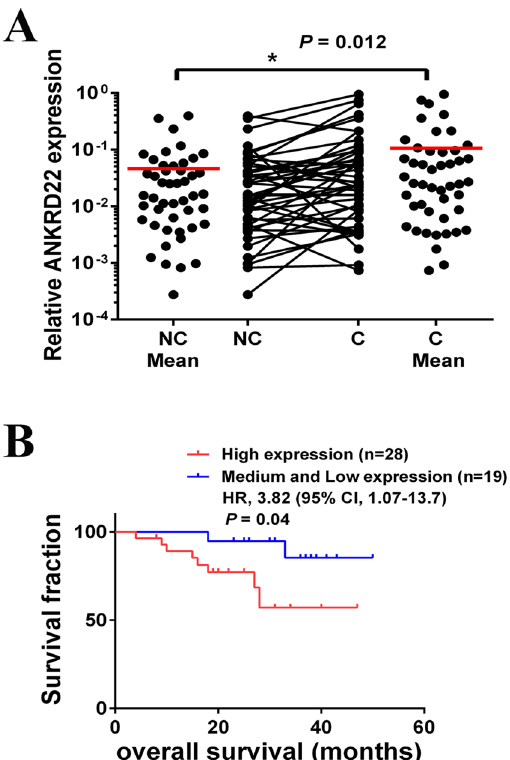
Figure 3. ANKRD22 expression levels were associated with poor prognosis of NSCLC. ( A ) Scatter plots of expression levels of ANKRD22 in NC and C tissues. NC, adjacent carcinoma tissues; C, primary carcinoma tissues. ( B ) Kaplan-Meier analysis of overall survival in NSCLC patients with primary tumors assessed for expression levels of ANKRD22. The P values correspond to hazard ratios (HR). (n = 3, * P <